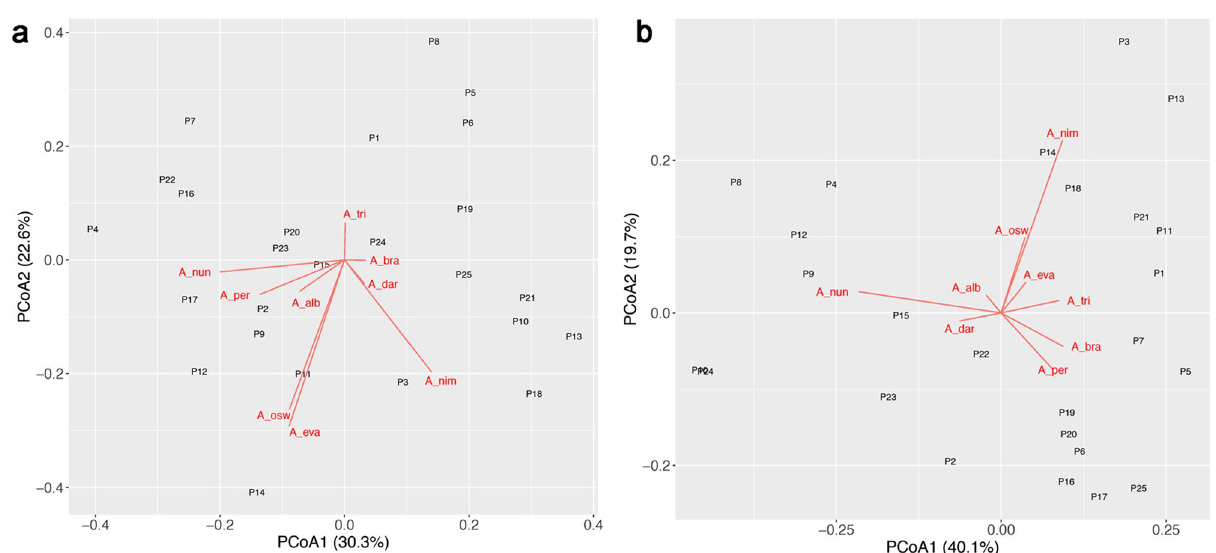
Figure 4. PCoA of anopheline larval assemblage composition in 25 sites in Manaus during the dry ( a ) and rainy ( b ) season. A_nun: Anopheles nuneztovari ; A_per: Anopheles peryassui ; A_alb: Anopheles albitarsis ; A_osw: Anopheles oswaldoi ; A_eva: Anopheles evansae ; A_tri: Anopheles triannulatus ; A_bra: Anopheles braziliensis ; A_dar: Anopheles darlingi ; A_nim: Anopheles nimbus ; Numbers are